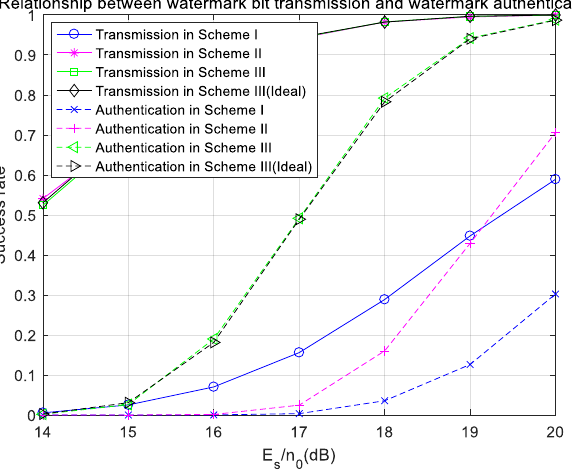
Figure 16. Success rates of watermark-bit transmission and watermark authentication with a fre- quency offset in the Gaussian channel.